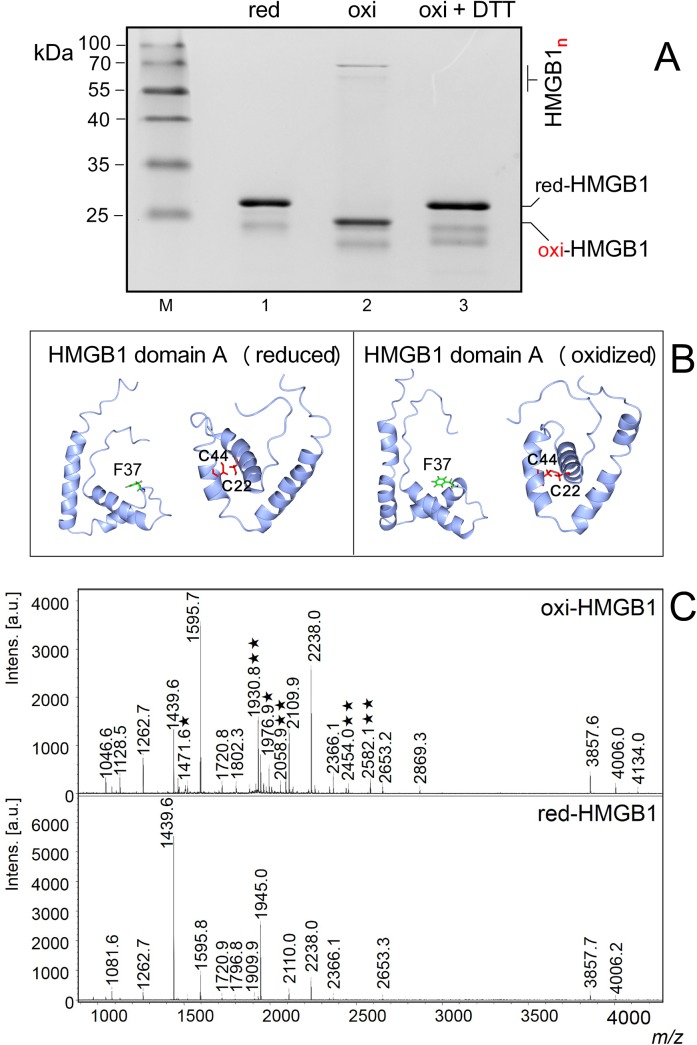
Oxidization of HMGB1 and analysis.
A, polyacrylamide SDS gel electrophoresis of reduced HMGB1 (lane 1), mildly oxidized HMGB1 (lane 2, intramolecular cross-links) and oxidized HMGB1 treated with 10 mM DTT (lane 3). HMGB1n indicates position of intermolecular cross-links of HMGB1. M, molecular mass of the protein markers. B, comparison of published NMR structures of reduced HMGB1 domain A [23] and oxidized HMGB1 domain A [24]. CCP4MG program was used to draw the NMR structures using coordinates from the Protein Data Bank (1AAB and 2RTU for the reduced and oxidized form of domain A, respectively). C, comparison between MALDI-TOF mass spectra of tryptic digests of reduced and oxidized HMGB1. **, signals corresponding to peptides containing disulphide bridges between Cys22 and Cys44; *, signals corresponding to peptides oxidized to cysteine sulfoxide (< 5%). The identity of the oxidized HMGB1 peptides was proved by MALDI-MS/MS analysis. None of these signals (data not shown) were observed in the reduced HMGB1 protein (lane 1 in panel A) or after reduction of the oxidized HMGB1 protein by DTT (lane 3 in panel A), suggesting that mild-oxidization of HMGB1 was fully reversible.